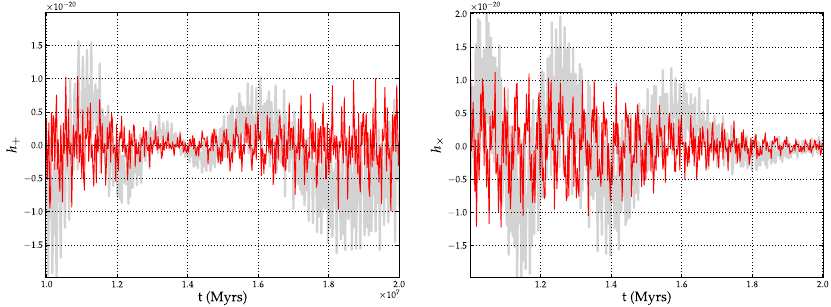
Fig.53 ZoomofFig.52.Forthetwofiguresonlyonepointoutof1600isusedtomaketheplotlighter.Still, we can see that even in the region of maximum overlap there is a significant difference. In the computation of the mismatch function of Eq. (95), however, the full waveform has been